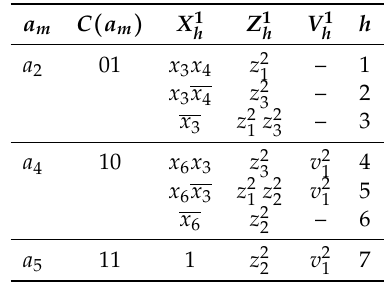
Table 5. Table of Block2 of Mealy FSM U 4 ( S 1 )